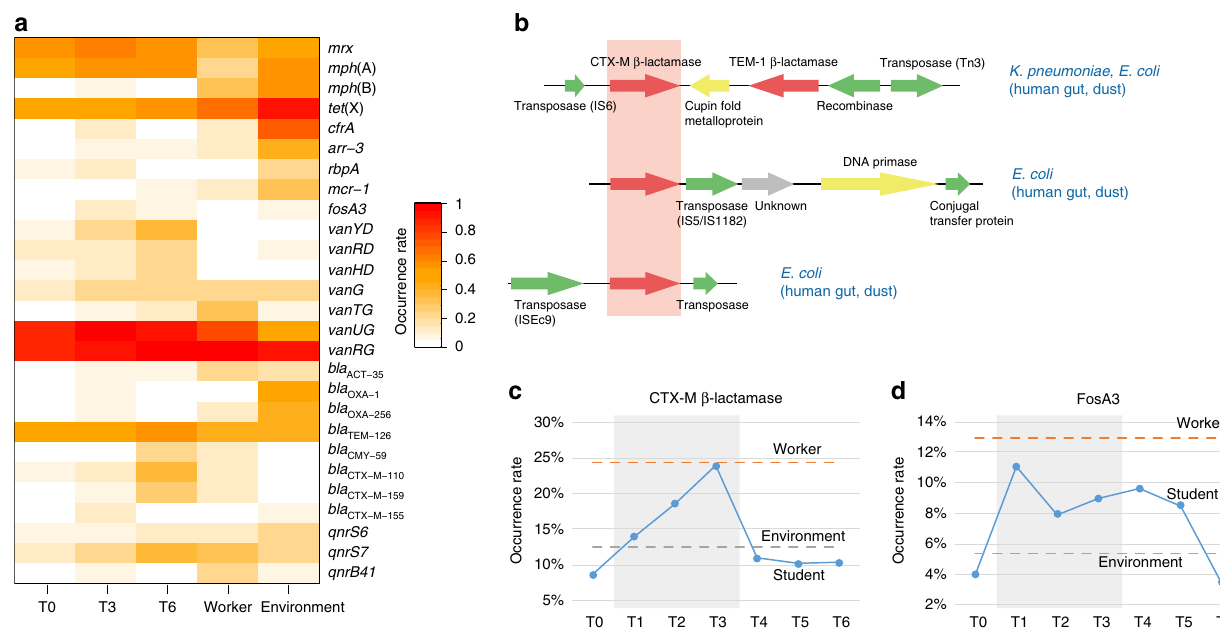
Fig. 4 Accumulation of important antibiotic resistance genes in the human gut. a Occurrence of the important antibiotic resistance genes in the microbiota of the students, the swine farm workers and the environment. Only important antibiotic resistance genes that were enriched in students ’ gut antibiotic resistomes during their swine farm stays (time point T3) are shown. The occurrence rates of antibiotic resistance genes in each group are represented by color shading. b Representative alignment of three contigs encoding a CTX-M β -lactamase with 99% nucleotide identity. The taxonomic assignments of the contigs are indicated on the right, and source metagenomic libraries are indicated inside the parenthesis. c and d Changes in resistance detection rate of the bla CTX-M gene c and fosA3 gene d among 1851 E. coli strains from students (blue), farm workers, and environment during the students ’ swine farm residence period. The dotted lines for worker and environmental samples are the average occurrence rate of resistance genes in E. coli strains from farm workers (orange) and environment (gray) in T1, T2, and T3. Underlying data are provided in the Source Data fi fosA3 from students ( n = 4), pigs ( n = 4), and compost soil ( n =